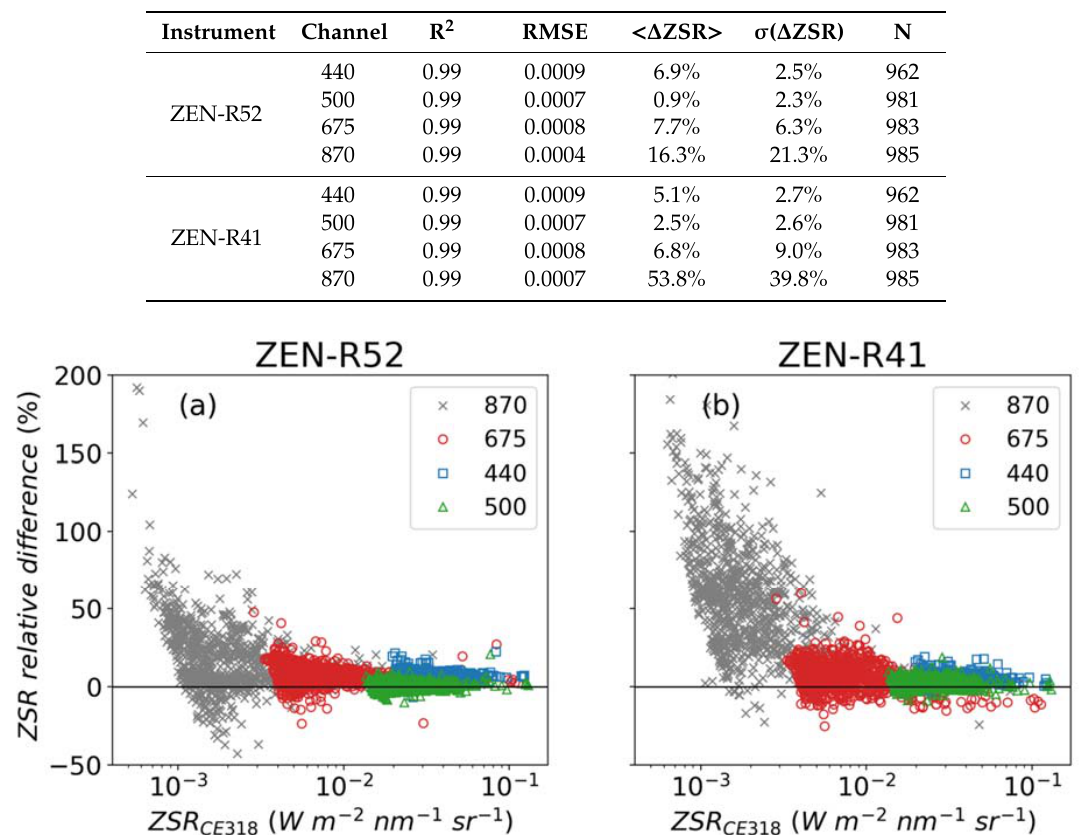
Table 2. Radiance comparison statistics by instrument and wavelength, taking CE318 ‐ AERONET ZSR measurements as references, including the coefficient of determination (R 2 ) and RMSE (W m ‐ 2 sr ‐ 1 nm ‐